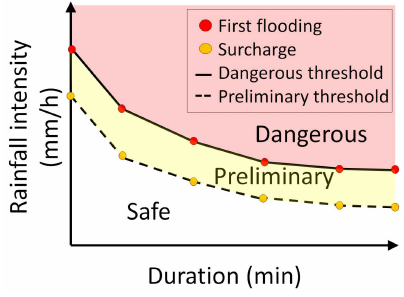
Figure 2. Concept of an advanced flood forecasting